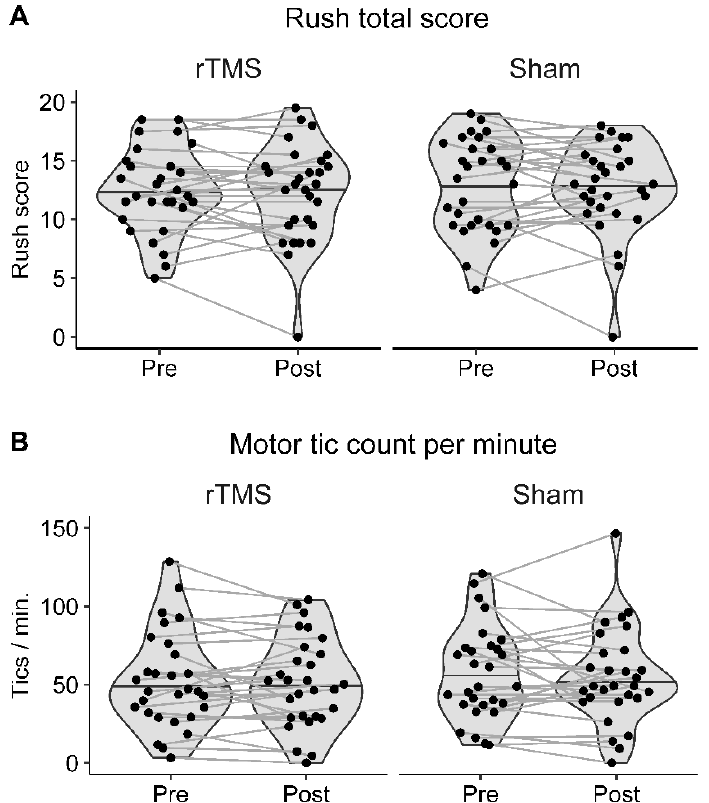
Figure 2. Illustration of Rush total scores and tic counts per minute. Pre- and post-rTMS ( A ) Rush total scores and ( B ) motor tic counts per minute of all participants in the rTMS and the sham stimulation condition are shown. The horizontal line in each violin plot denotes the median.